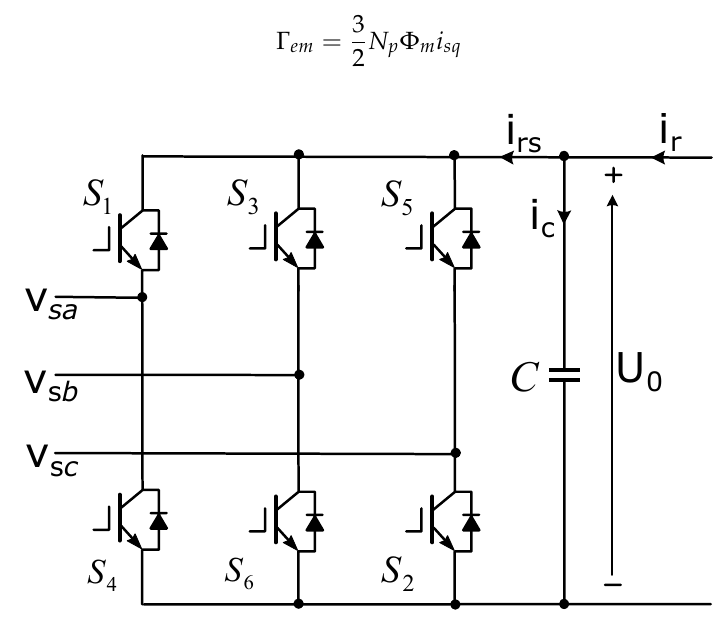
Figure 7. PMSM-side converter